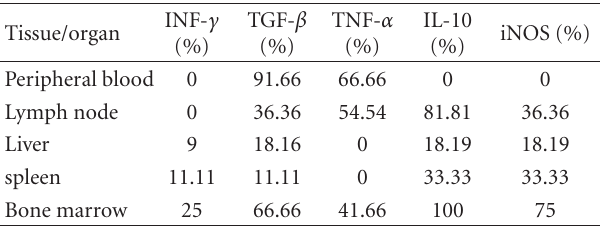
INF- γ : interferon-gamma; TGF- β : transforming growth factor-beta; TNF- α : tumour necrosis factor-alpha; IL-10: interleukin-10; iNOS: inducible nitric oxide